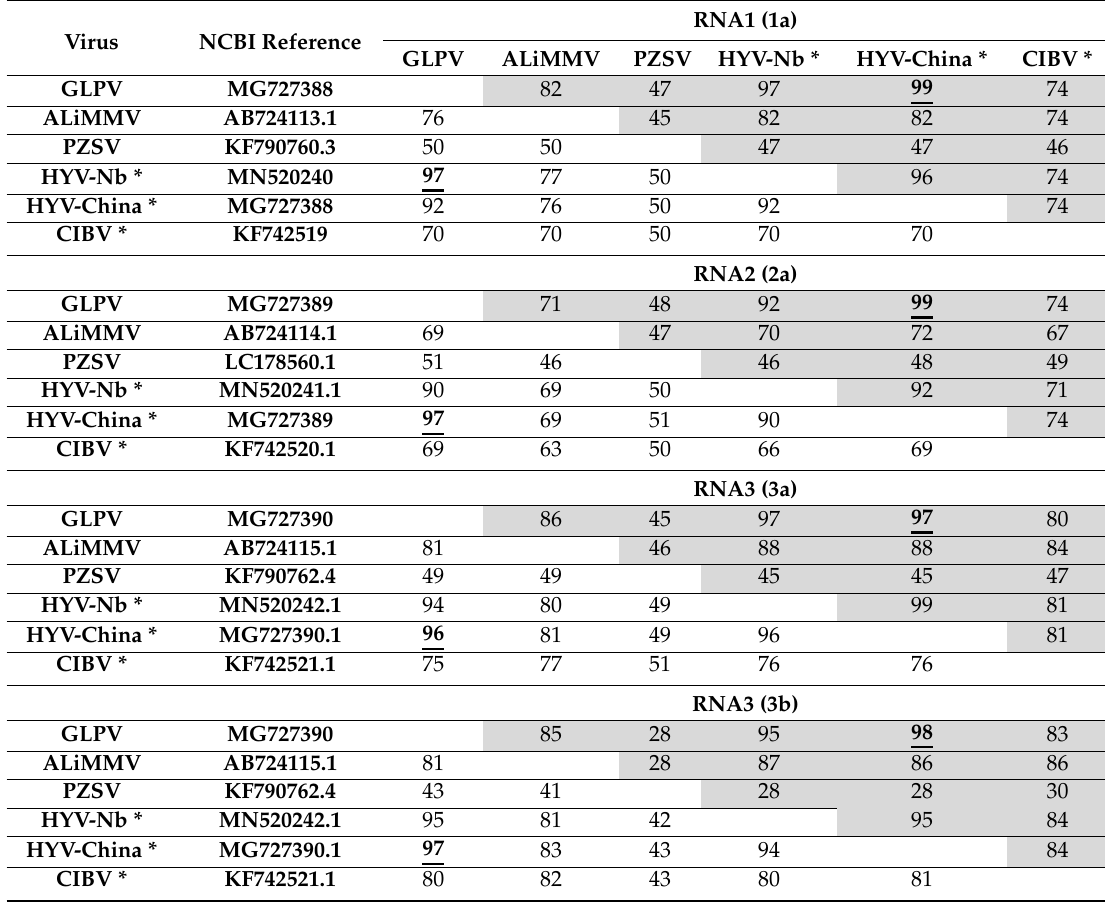
Table 1. Pairwise nucleotide and amino acid sequence identity (in %) of genomic RNAs of GLPV with corresponding regions of closely related members (and tentative members*) of the genus Anulavirus. Values for amino acids are shadowed. Underlined bold numbers indicate the highest identity found between GLPV sequences and those of other